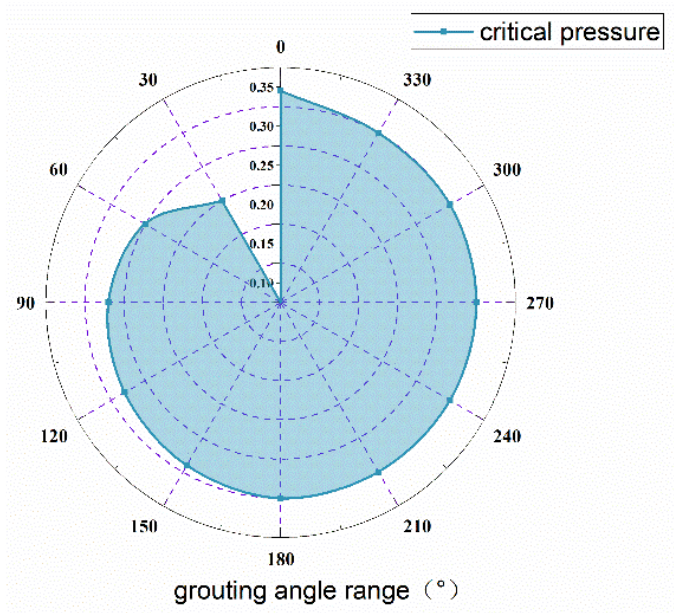
Figure 11. Comparison of water pressure resistance of stone bodies under different grouting ranges.